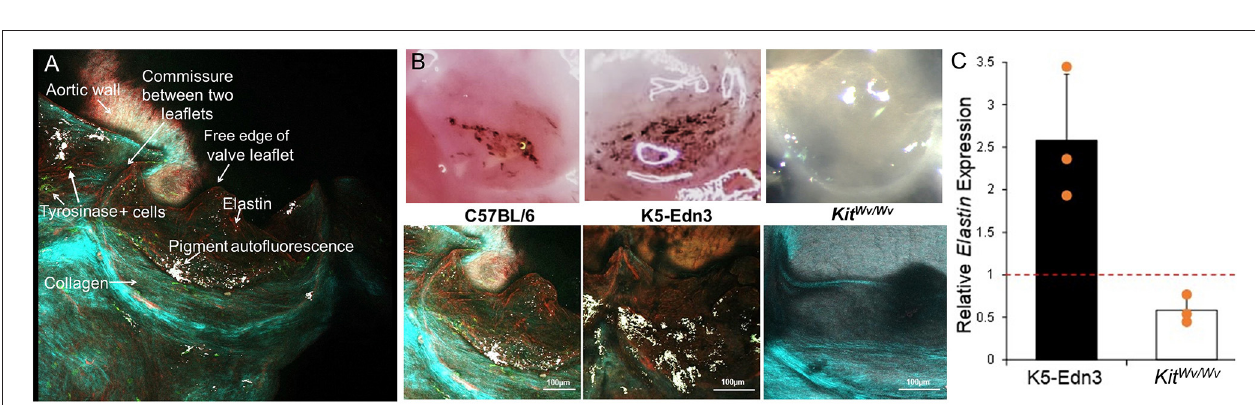
FIGURE 5 | ECM analyses in mice with altered melanocytic populations. (A) En face imaging of a mouse AV leaflet with GFP-labeled Tyr + cells (green) using two-photon microscopy. Second harmonic generation identifies collagen fibers (light blue/green) and autofluorescence associates with elastin (red) and melanin pigment (white). (B) Top panel: photographs under a dissection microscope to demonstrate relative amounts of pigment in AV leaflets from C57BL/6, K5-Edn3, and Kit Wv / Wv mice. Bottom panel: two-photon imaging of second harmonic generation identified collagen fibers (light blue/green) and elastin (red) and melanin pigment (white) autofluorescence in AV leaflets from C57BL/6, K5-Edn3, and Kit Wv / Wv mice. (C) qPCR analysis of elastin gene expression from AV leaflets from K5-Edn3 and Kit Wv / Wv mice ( N = 3 per group) normalized to C57BL/6 gene expression (dotted